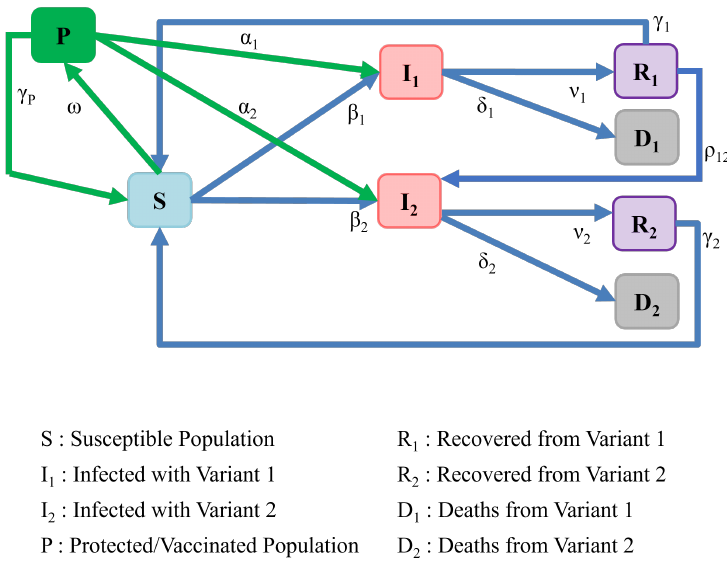
Figure 14. Model of population interactions with different variants, and vaccinated